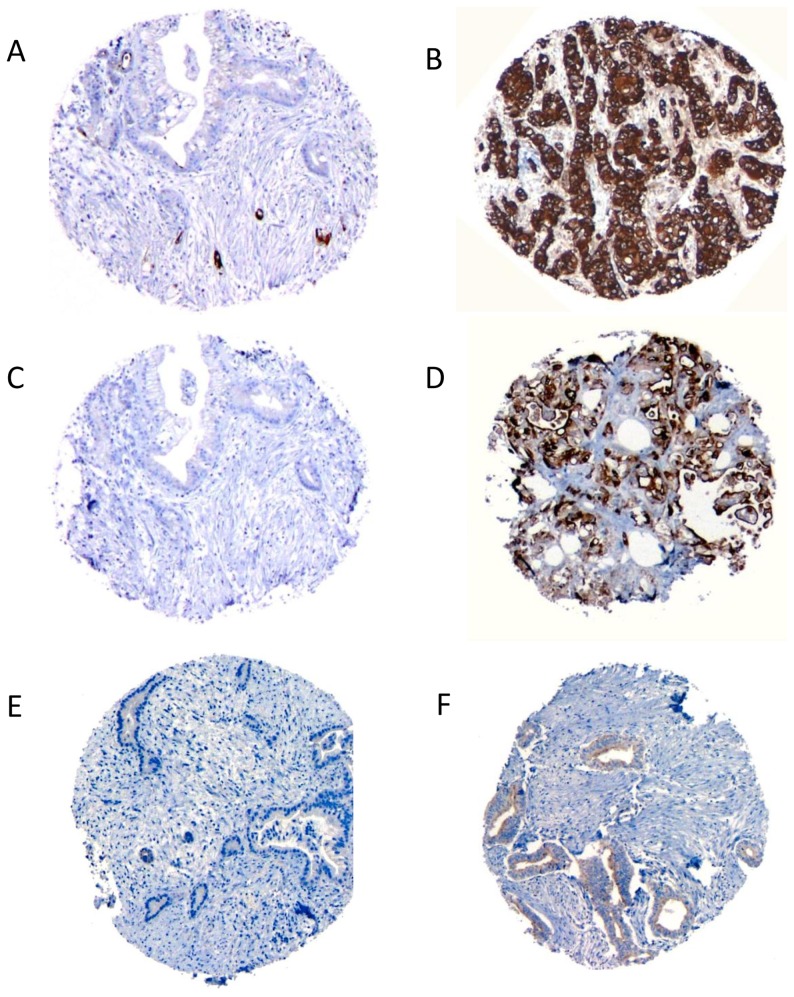
Representative immunolabeled slides: A) MUC1, 0; B) MUC1, 3+; C) MSLN, 0; D) MSLN, 3+; E) MUC2, negative; F) MUC2, positive.